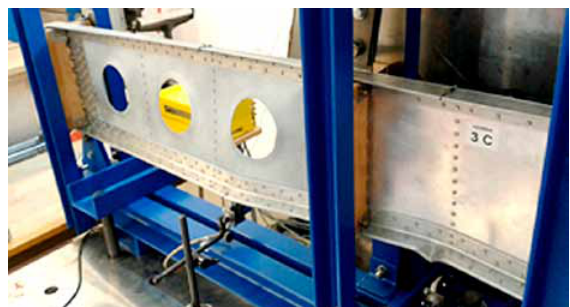
Fig. 7. Specimen 3C after the